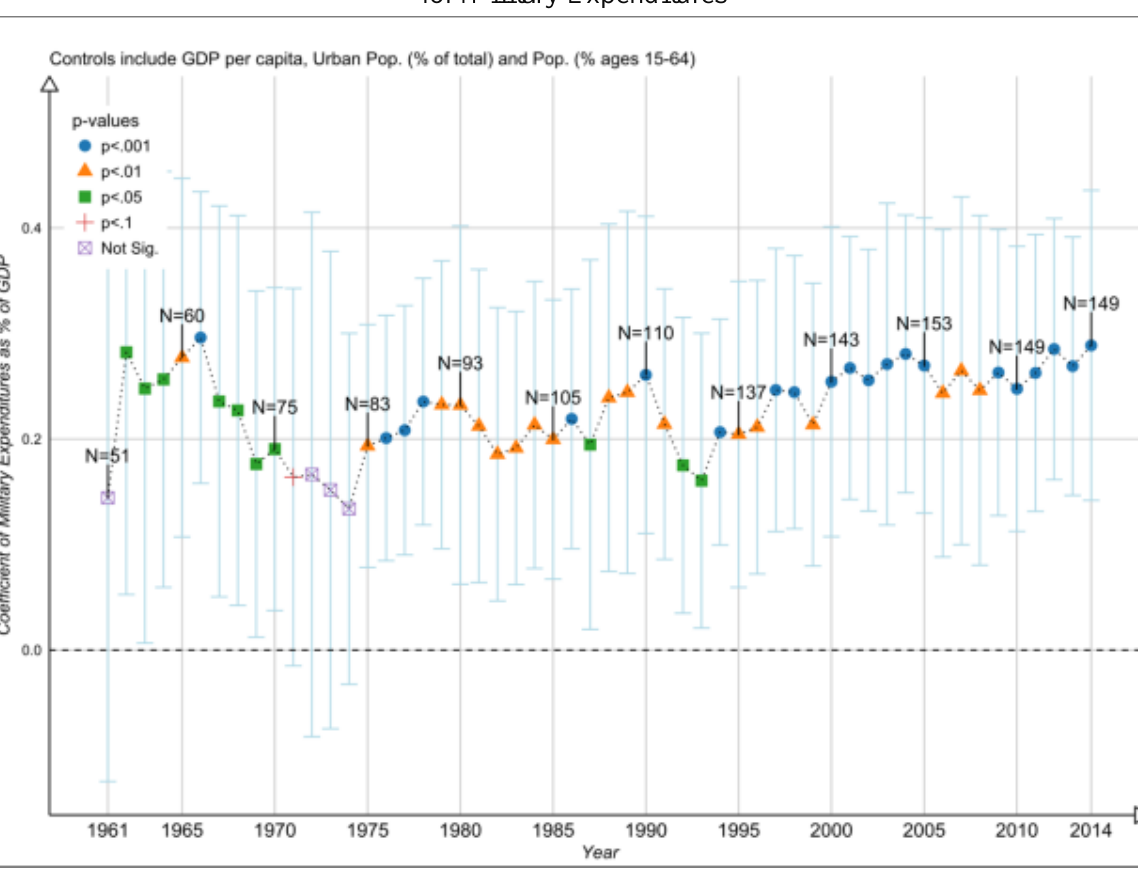
Figure 4. Cross-Sectional Robust MM Regression Coefficients & Confidence Intervals for Military